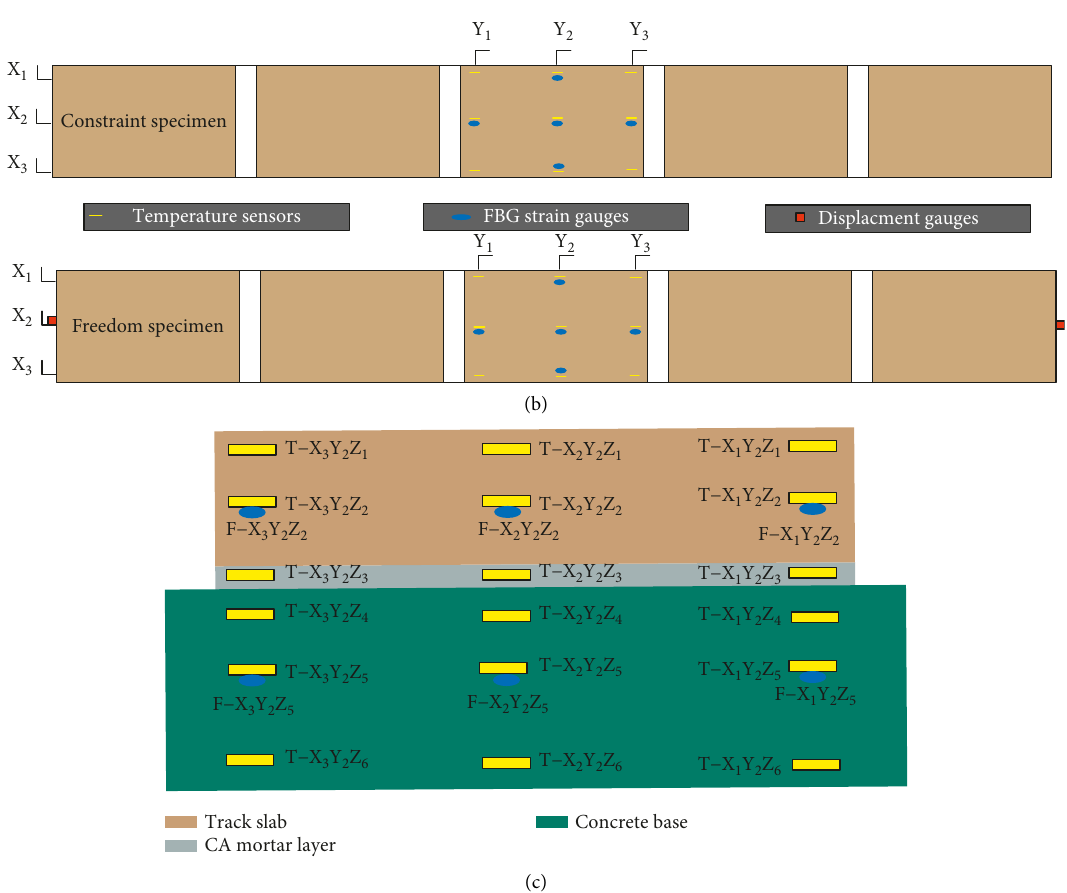
Figure 4: The sensors attached to the scaled specimen: (a) side view (test section), (b) plan view of sensors, and (c) vertical arrangement of sensors.